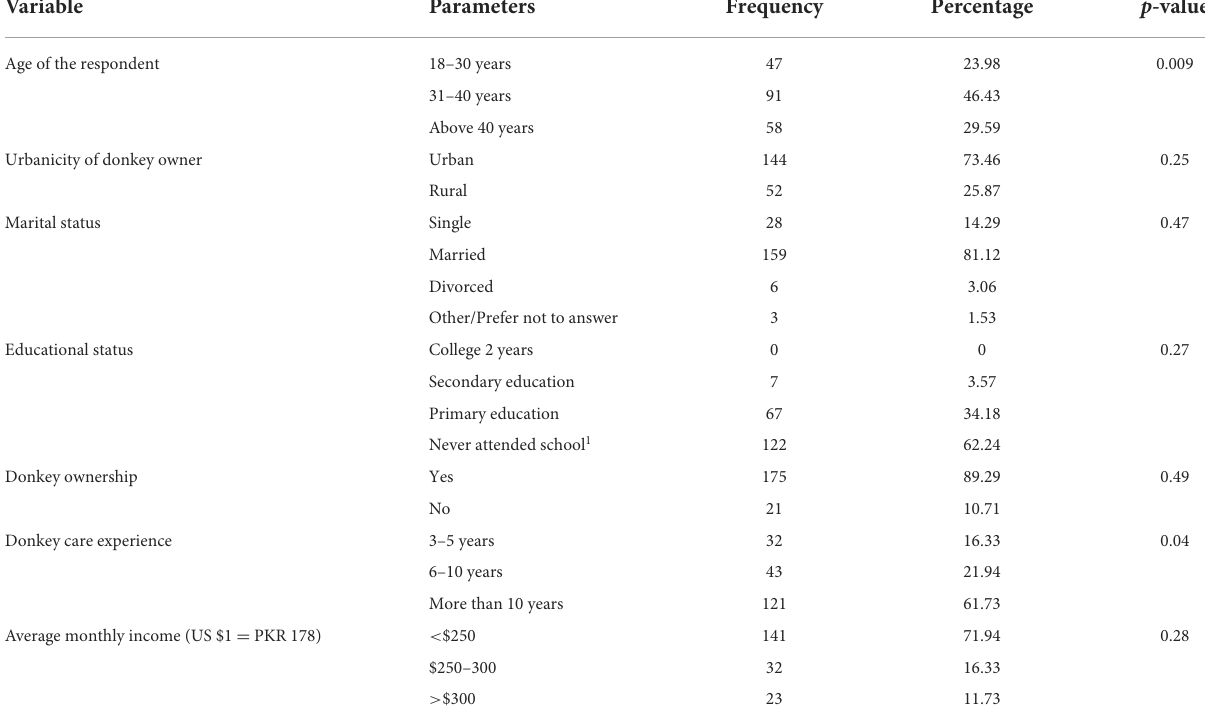
TABLE 1 Sociodemographic breakdown of survey respondents.